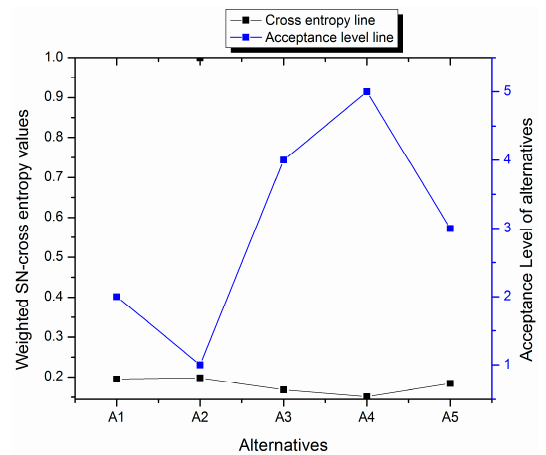
Figure 2. Bar diagram of alternatives versus weighted NS-cross entropy values of alternatives.